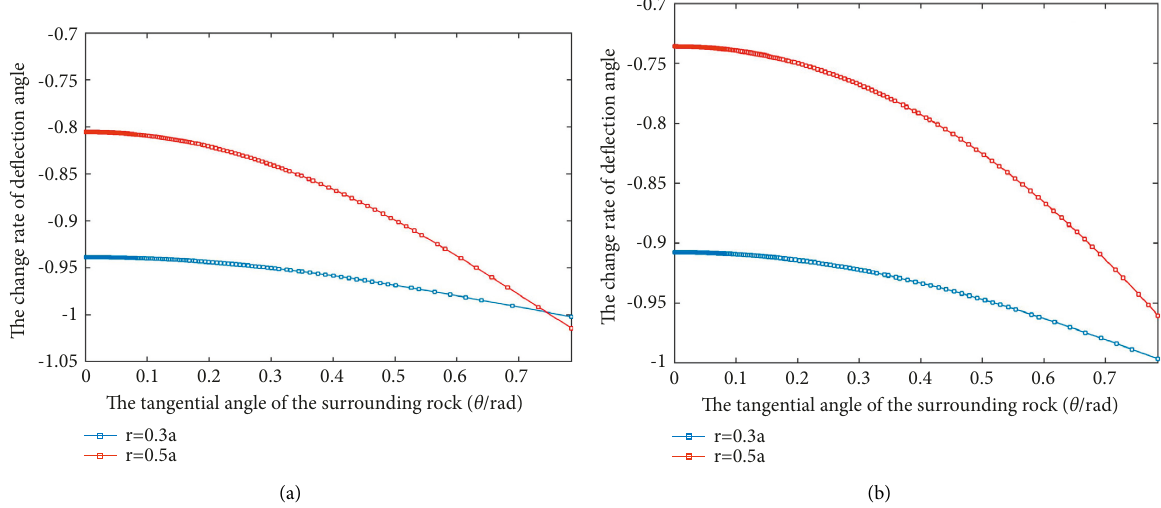
Figure 9: Tangential change rate of principal stress rotation of surrounding rock stress element. (a) λ � 0.3. (b) λ �